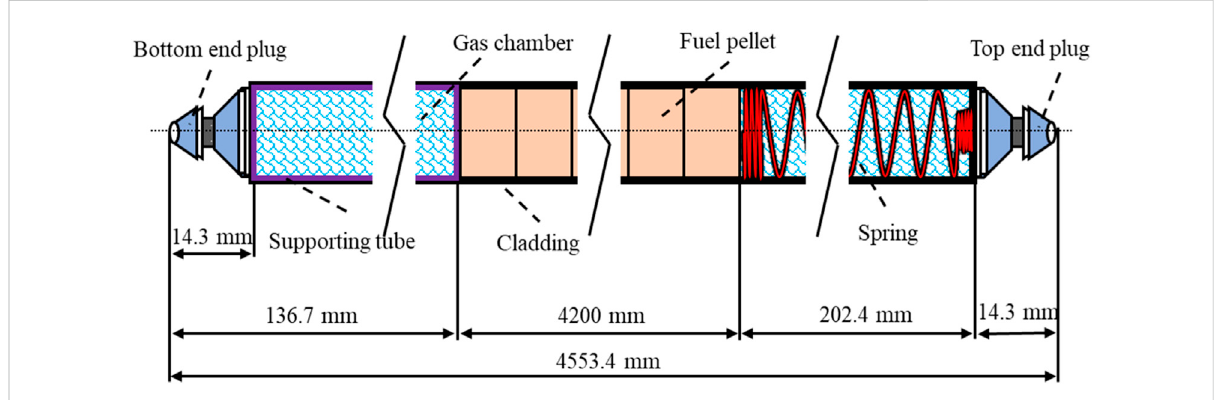
FIGURE 2 Schematic diagram of the fuel rod of